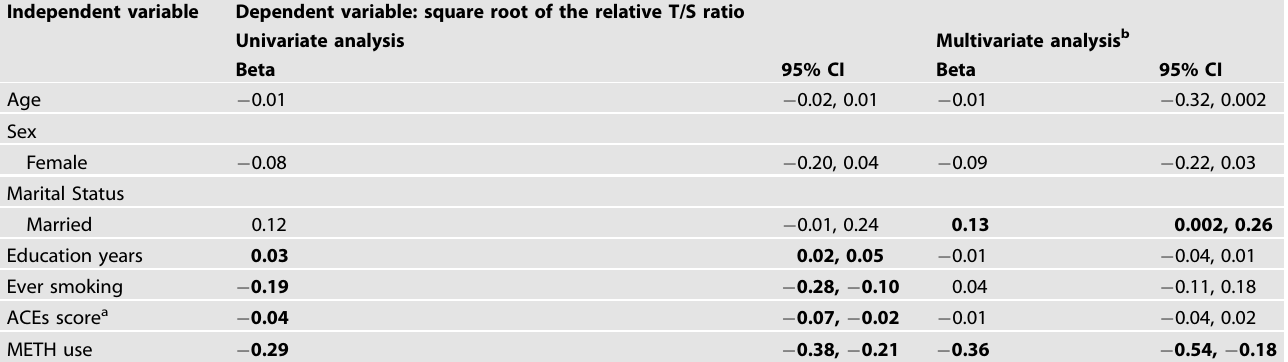
Table 2. Univariate and multivariate linear regression to examine the association of telomere length (dependent variable) with demographic, clinical, and METH use variables (independent variables) for the entire sample ( N =